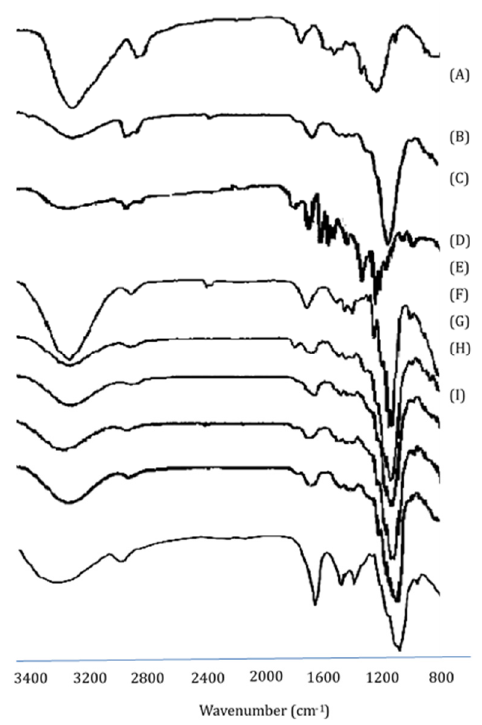
Figure 1. FTIR spectra of commercial cellulose ( A ); sago biomass ( B ); commercial lignin ( C ); Figure 1. FTIR (Infrared Spectroscopy) spectra of commercial cellulose ( A ); sago biomass ( B